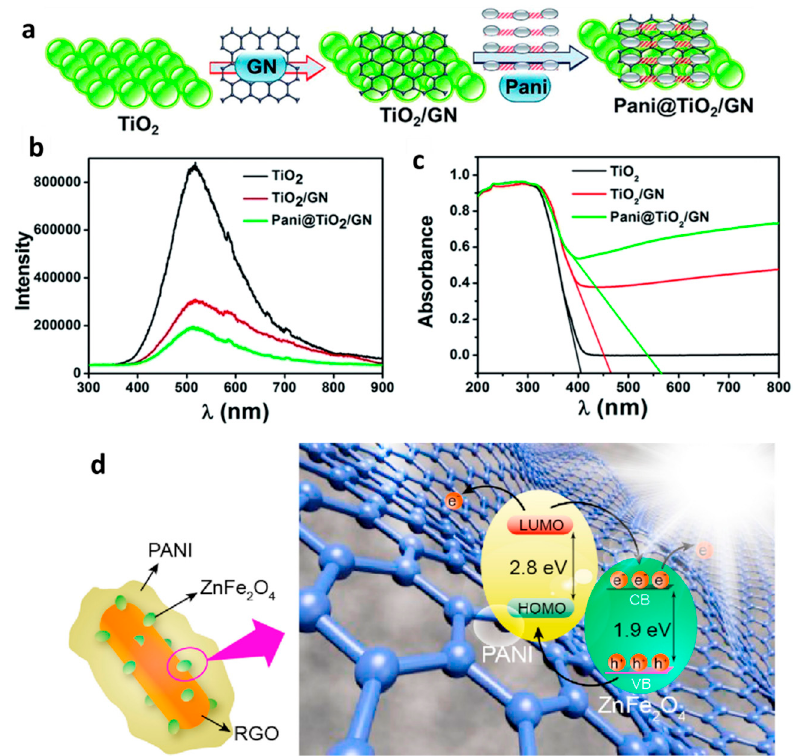
Figure 4. ( a ) Schematic representation of the synthesis of PANI/TiO 2 /graphene nanocomposite ( b ) PL and ( c ) UV–Vis diffuse absorbance spectra of TiO 2 , TiO 2 /GN and PANI/TiO 2 /graphene nanocomposite [39]. ( d ) Microstructure and photocatalytic mechanism diagram of ternary GO-ZnFe 2 O 4 -PANI composite [36].